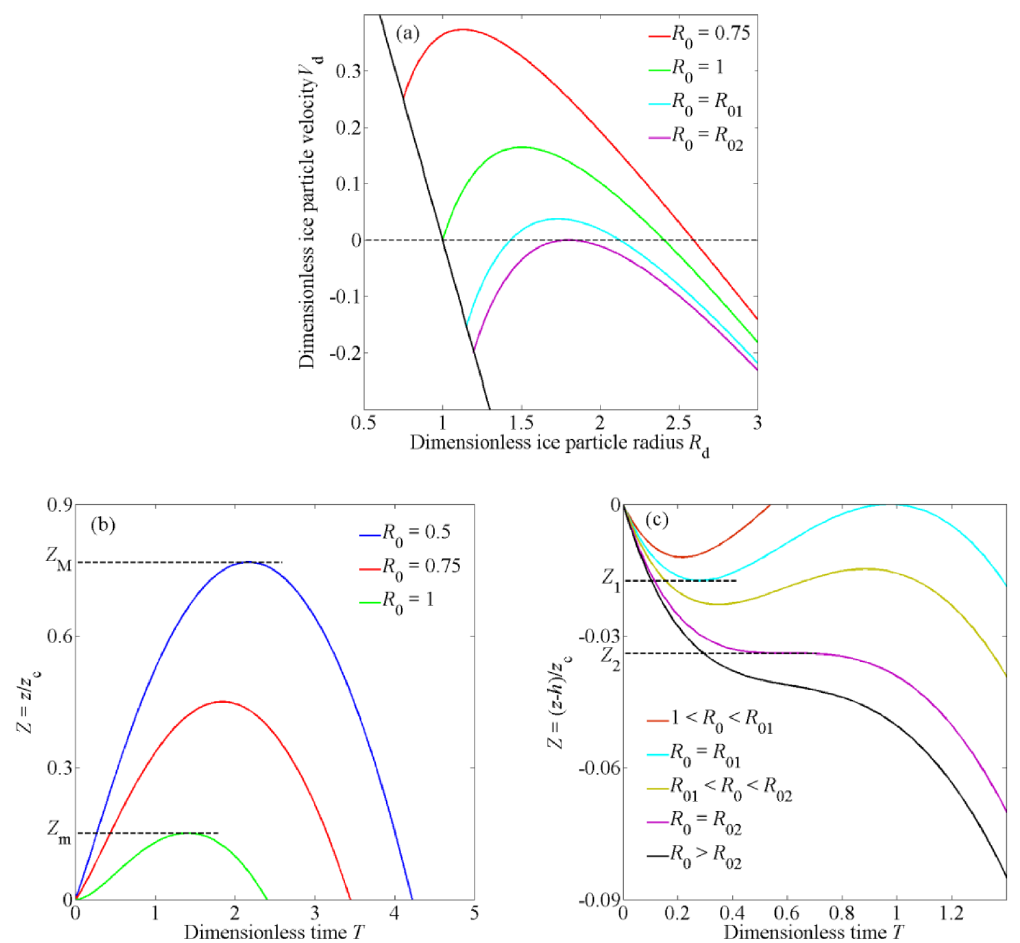
Figure 1. (a) Dependence of the ice particle velocity on radius for different initial nucleus radii. The black solid line V d 0 = 1 − R 0 represents the relation between the initial particle velocity and the initial particle radius. (b) Movement curves of ice particles near the lower boundary. (c) Movement curves of ice particles near the upper